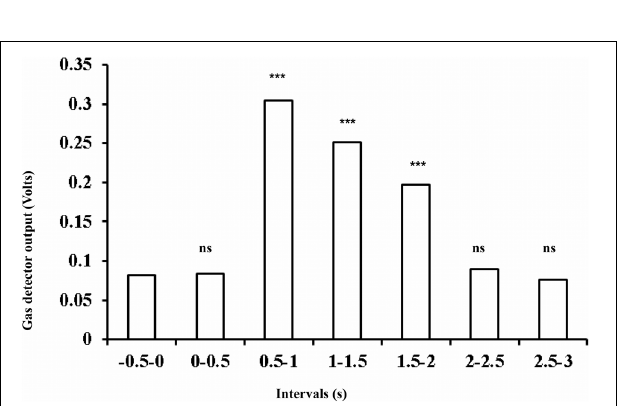
FIGURE 11 | Mean gas detector output values for the six 500ms periods and the baseline. ns, non-significant, ∗∗∗ = p < 0 . 001